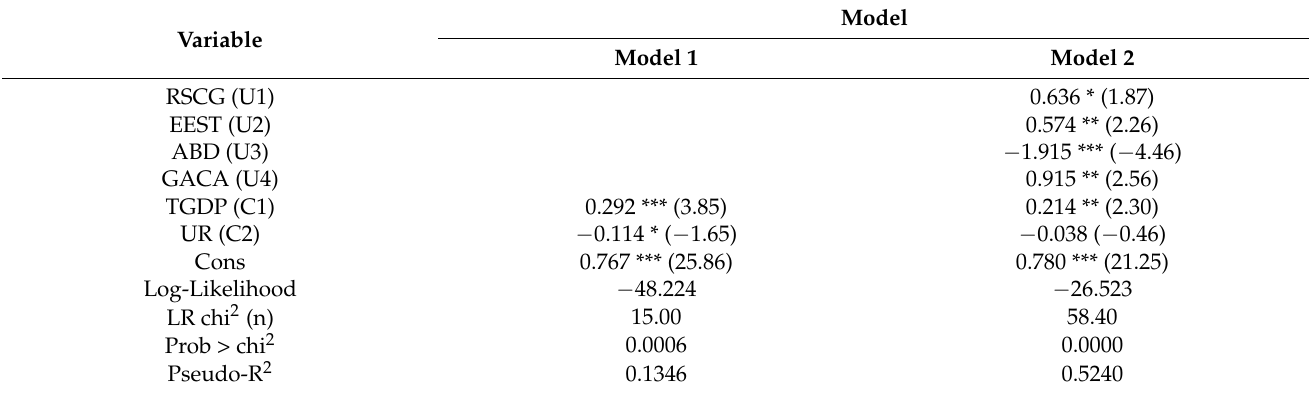
Table 3. Tobit regression results with full sample.